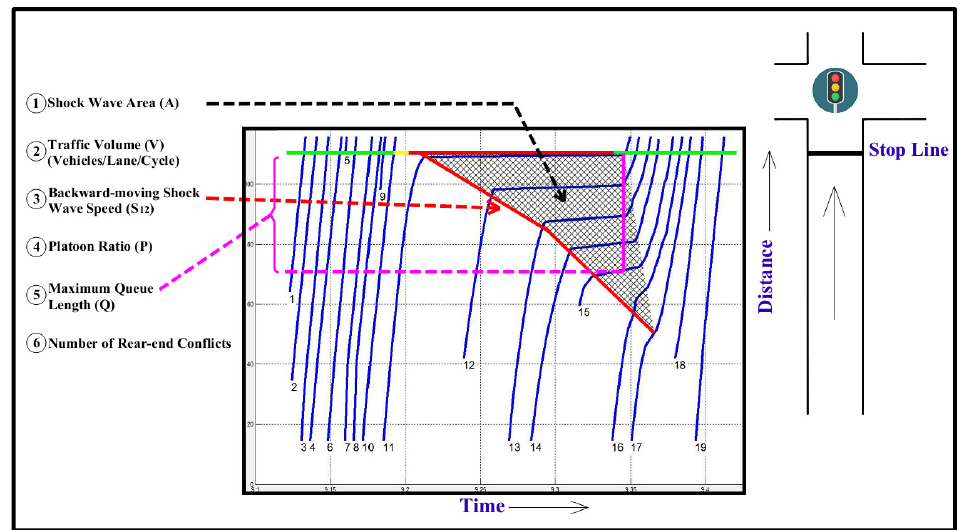
Figure 1. Shockwave parameters and traffic conflict models (Essa and Sayed 2018).